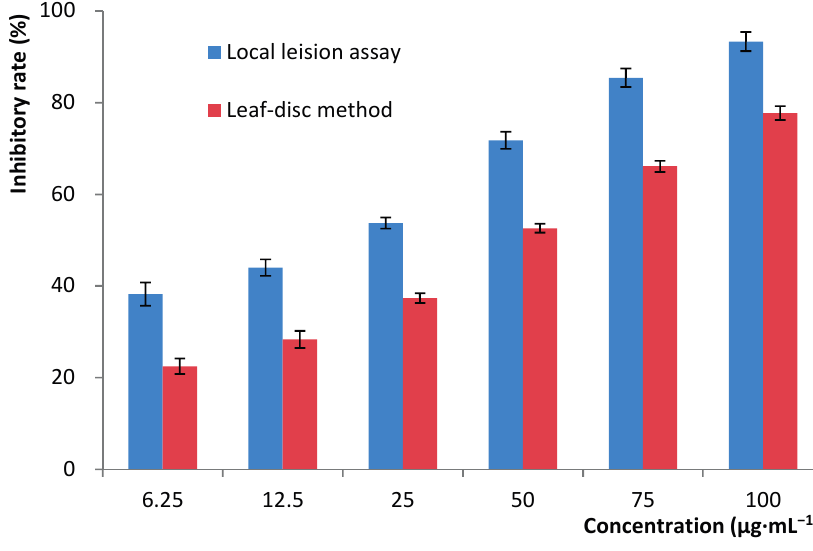
Figure 4. Dose-dependent inhibition of malformin A 1 against the replication of TMV as tested by using local lesion assay and leaf-disc method. Error bar: